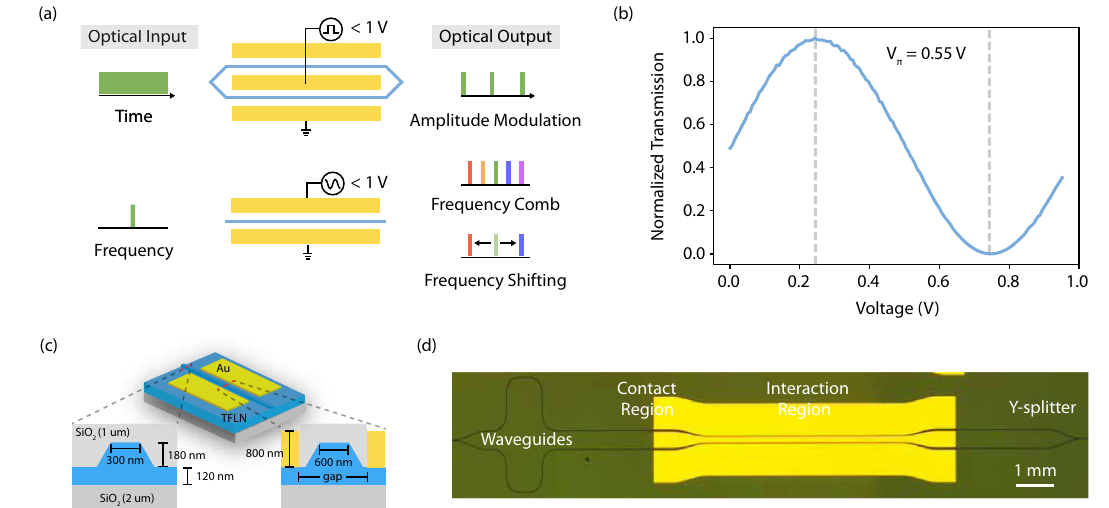
Fig. 1 | Ultra-low V π modulators operating at visible-to-near-infrared wavelengths. a In the time domain, VNIR amplitude modulators with ultra-low drive voltages (<1V) can modulate continuous-wave optical inputs at CMOS vol- tages. Similarly, sub-volt phase modulators enable VNIR frequency comb genera- tion and frequency shifting over multiple pulse bandwidths. b Normalized optical transmission of a 10mm long amplitude (Mach-Zehnder) modulator as a function